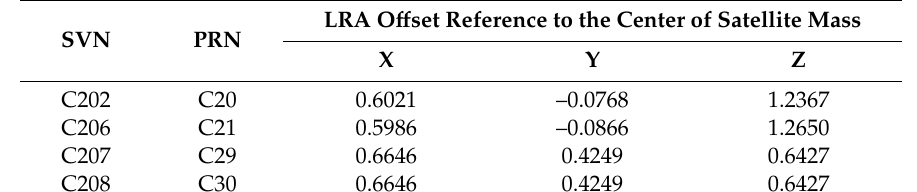
Table 7. The BD3 MEO laser retroreflector array (LRA) o ff set reference to the center of the satellite mass (units: m)